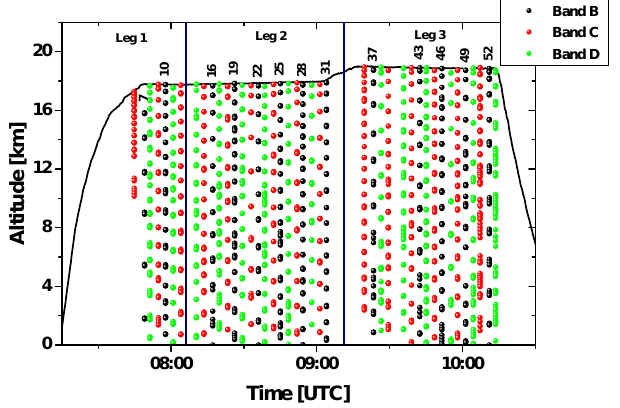
Figure 1. The flight altitude and MARSCHALS tangent points plot- ted vs. the acquisition time (UTC) for the Arctic Geophysica flight on 10 March 2010.